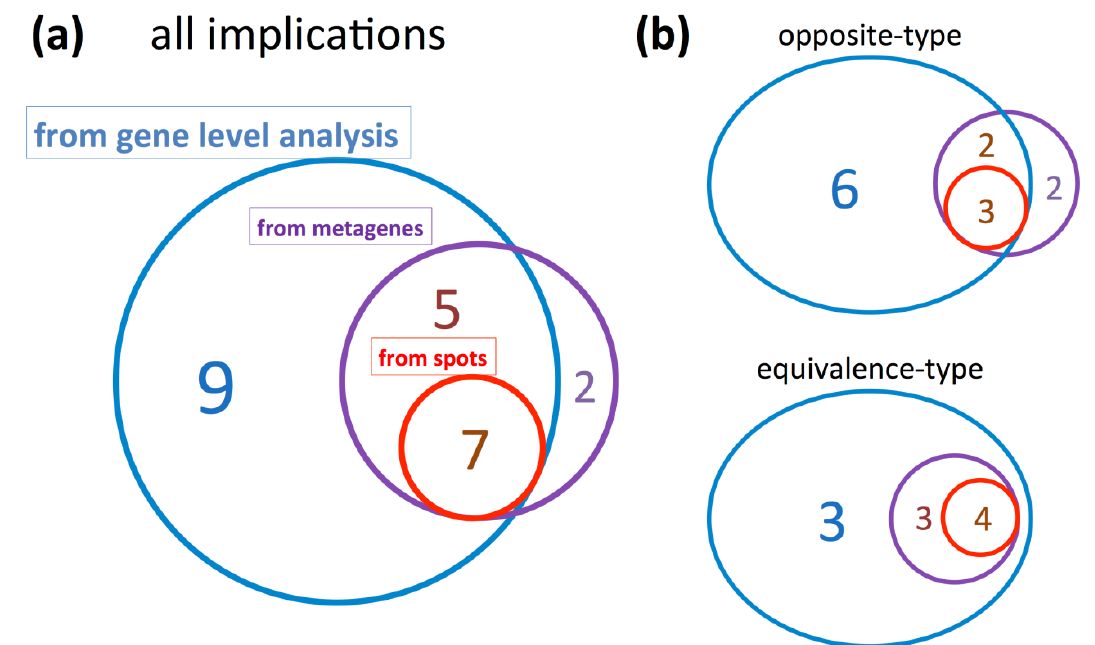
Figure 10: Venn diagrams of spot module relations. Spot module relations derived from single gene profile implication analysis (blue circles), from metagene profiles (purple circles) and spot module profiles (red circles), respectively. Total numbers for all relations are given (panel a) as well as numbers seperated for opposite and equivalence types, respectively (panel b). The number of implications markedly decreases if one uses higher levels of data integration for extracting